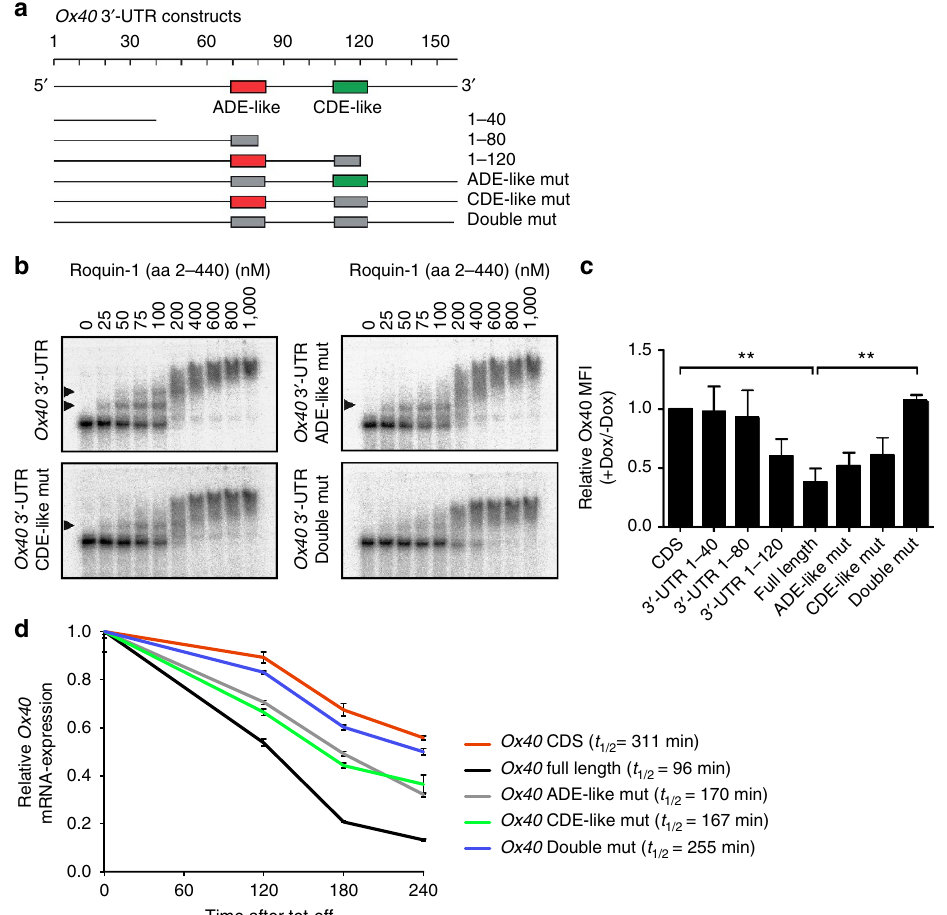
Figure 6 | Functional importance of Roquin-1 target motifs in cells. ( a ) Overview of the Ox40 3 0 -UTR and truncated/mutated versions thereof as used for EMSA assays in b and the expression experiments of Ox40 in c and d . ( b ) EMSA experiments probing the interaction between the Roquin-1 N-terminal region (residues 2–440) and either the complete wild-type Ox40 3 0 -UTR or versions with mutations of the CDE-like SL, the ADE-like SL or both SLs (see a ). Arrows indicate the individual binding events to either motif. It is noteworthy that the higher bands observed at large protein concentrations are probably additional nonspecific, lower-affinity interactions of Roquin-1 with the 3 0 -UTR or protein aggregates. ( c ) Relative Ox40 MFI normalized to expression levels from the Ox40 CDS construct. Error bars show s.d. of seven (CDS, 1–40, 1–80, 1–120 and full-length), six (ADE-like mut and CDE mut) or three (double mut) independent experiments. Statistical significance was calculated by one-way analysis of variance (ANOVA) Kruskal–Wallis test followed by Dunn’s multiple comparison test (** P o 0.01). ( d ) mRNA decay curves of Hela Tet-Off cells stably transduced with retroviruses expressing Ox40 CDS without 3 0 -UTR (CDS, red line), Ox40 CDS with its wild-type 3 0 -UTR (full length, black line), Ox40 full length with mutated ADE-like motif (ADE-like mut, grey line), Ox40 full length with mutated CDE-like motif (CDE-like mut, green line) or Ox40 full length with mutated ADE and CDE motifs (Double mut, blue line). Error bars represent the mean of technical duplicates in one experiment. mRNA half-life times were calculated with Graph Pad Prism. Data are representative of two experiments with similar results.